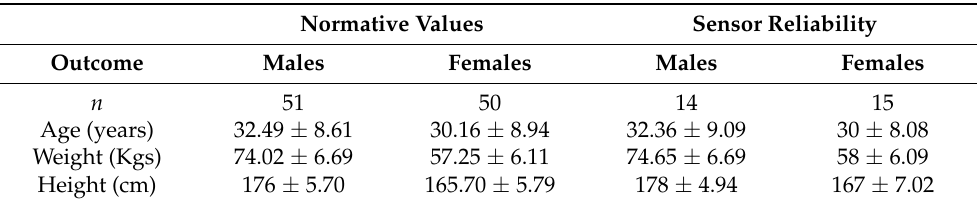
Table 1. Demographic data of participants to establish normative values and sensor reliability according to sex. Values are presented with mean and standard deviation (SD).